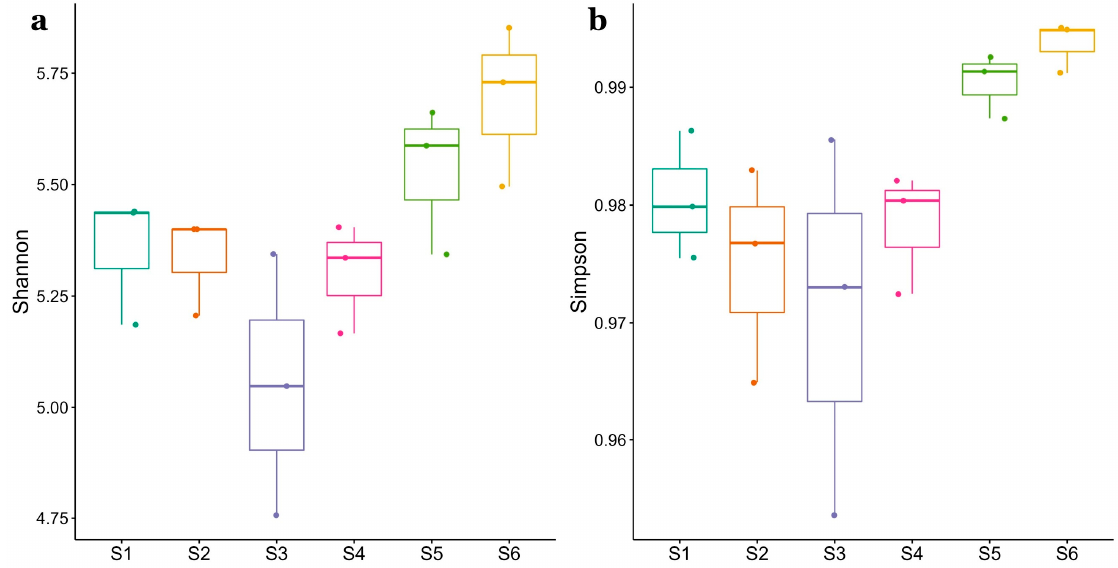
Figure 2. Box plots showing alpha diversity metrics for the six sampling stations (S1–S6). Shannon ( a ) and Simpson ( b ) indexes are presented, and bars are colored by sampling sites. Minimum, maximum, mean values and standard deviation correspond to the triplicate of each of the six sampling stations.